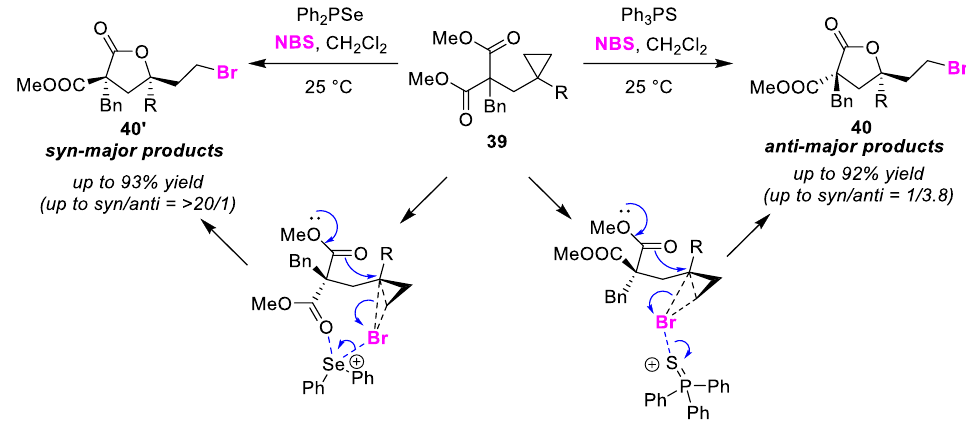
Figure 20. Syn/anti selective bromolactonizations of cyclopropyl diesters 39 using chalcogenide catalysts.